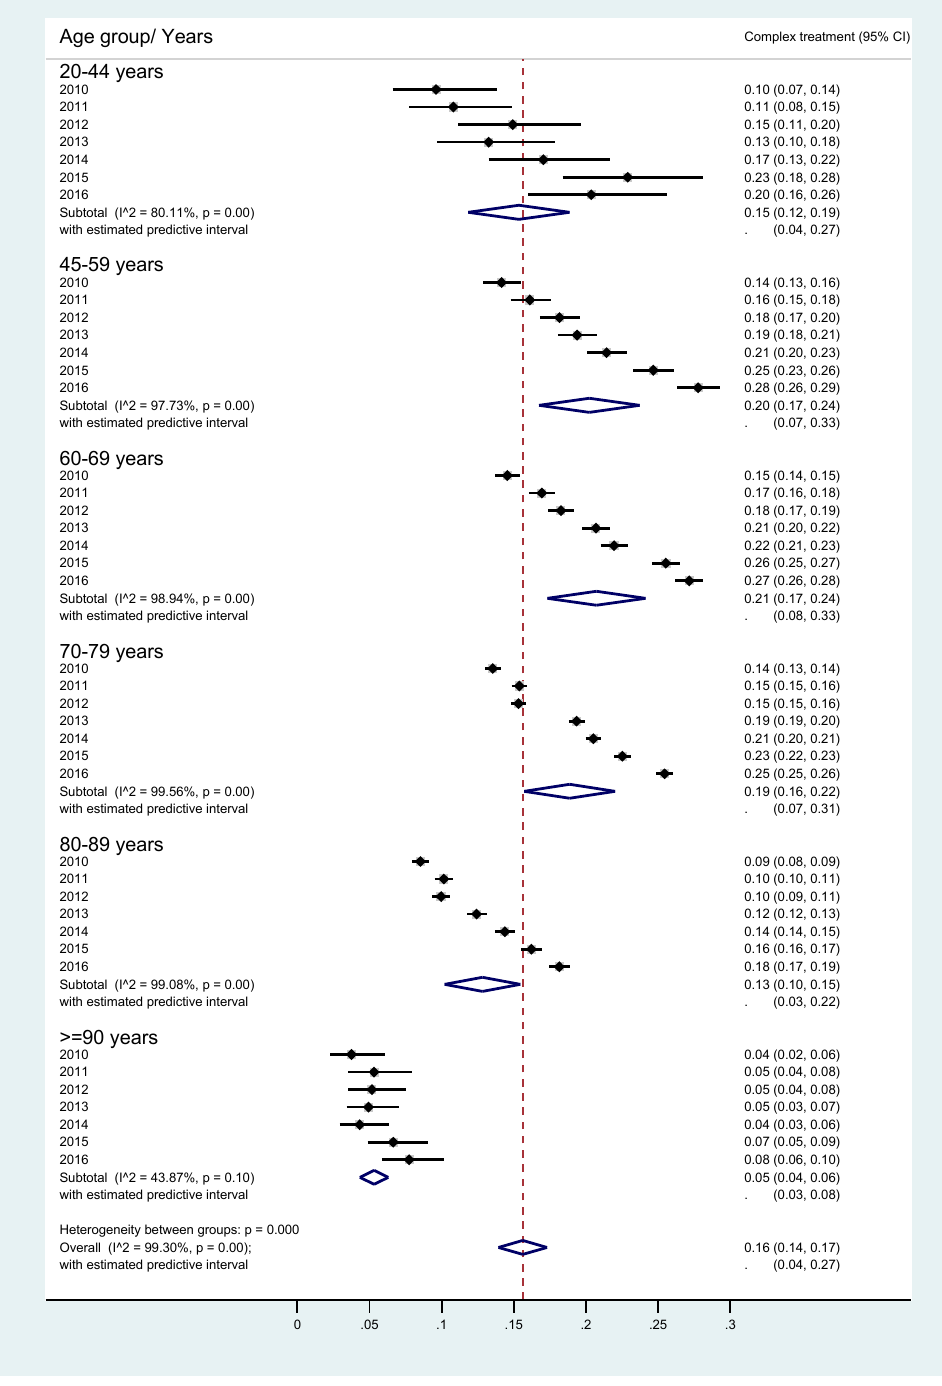
Figure 4. PD-MCT rates for primary Parkinson syndrome from 2010–2016 stratified by age group. Horizontal bars depict percentages and 95% confidence intervals (CI) to receive PD-MCT in relation to all stationary PD treatments in specified years for predefined age groups. Diamonds depict respective averages of the years 2010–2016 for predefined age groups and the overall